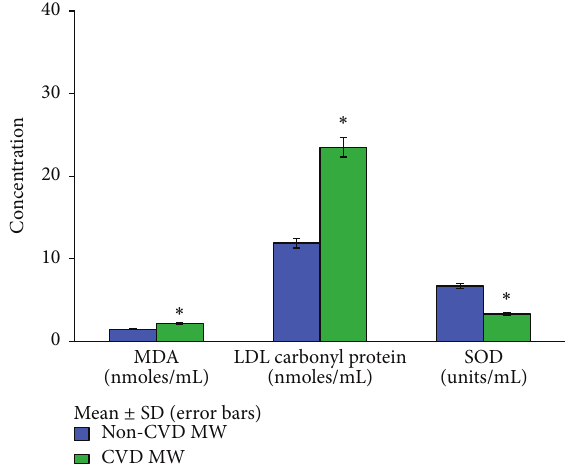
Figure 4: Levels of MDA, LDL carbonyl content, and SOD in hyperlipidemic CVD and non-CVD menopausal women. MDA, malondialdehyde; SOD, superoxide dismutase. ∗ 𝑝 < 0.05 significant difference observed in the levels of MDA, LDL carbonyl protein, and SOD between hyperlipidemic CVD and non-CVD menopausal